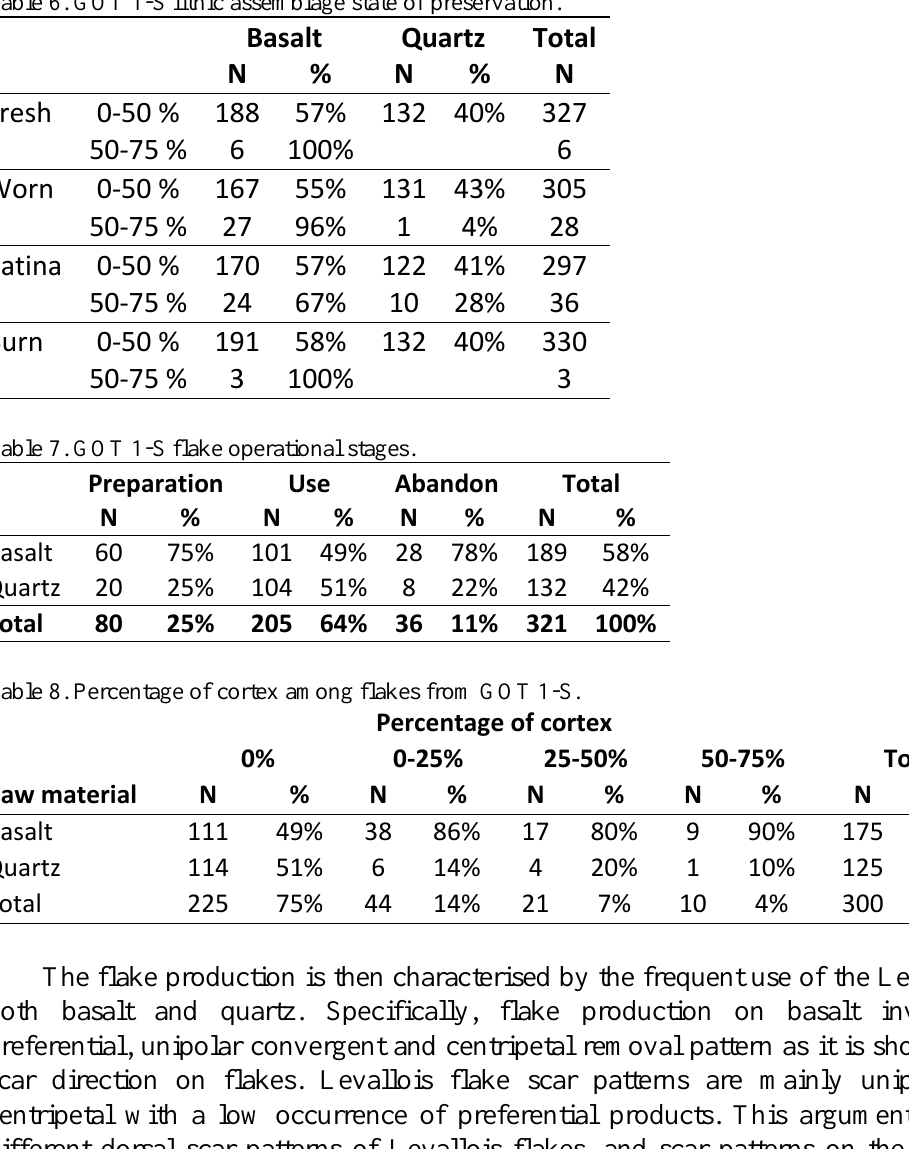
Table 6. GOT 1-S lithic assemblage state of preservation.